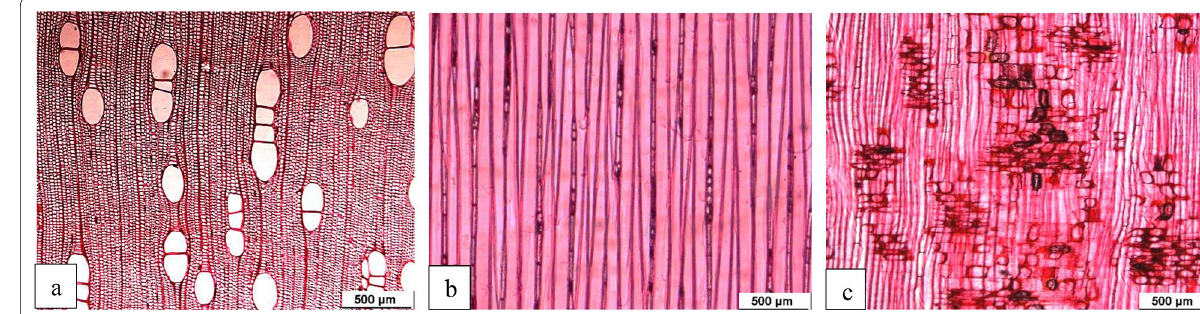
Fig. 3 Mahang: ( a ) tranverse section, ( b ) tangential section, and ( c ) radial section